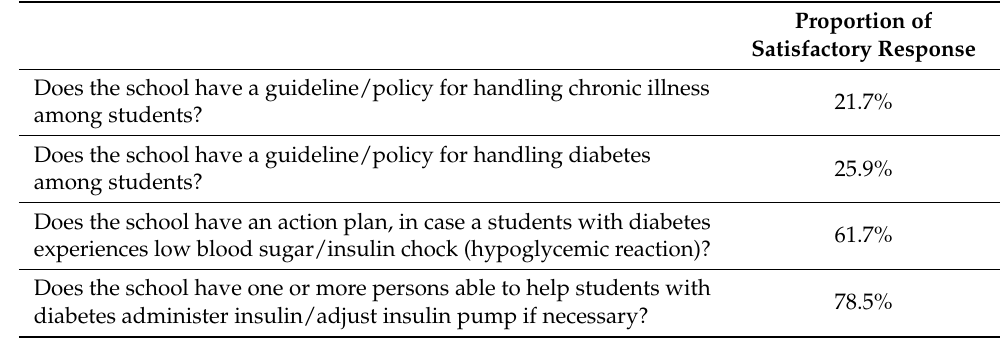
Table 3. Overview of single-item questions and subsequent proportion of satisfactory